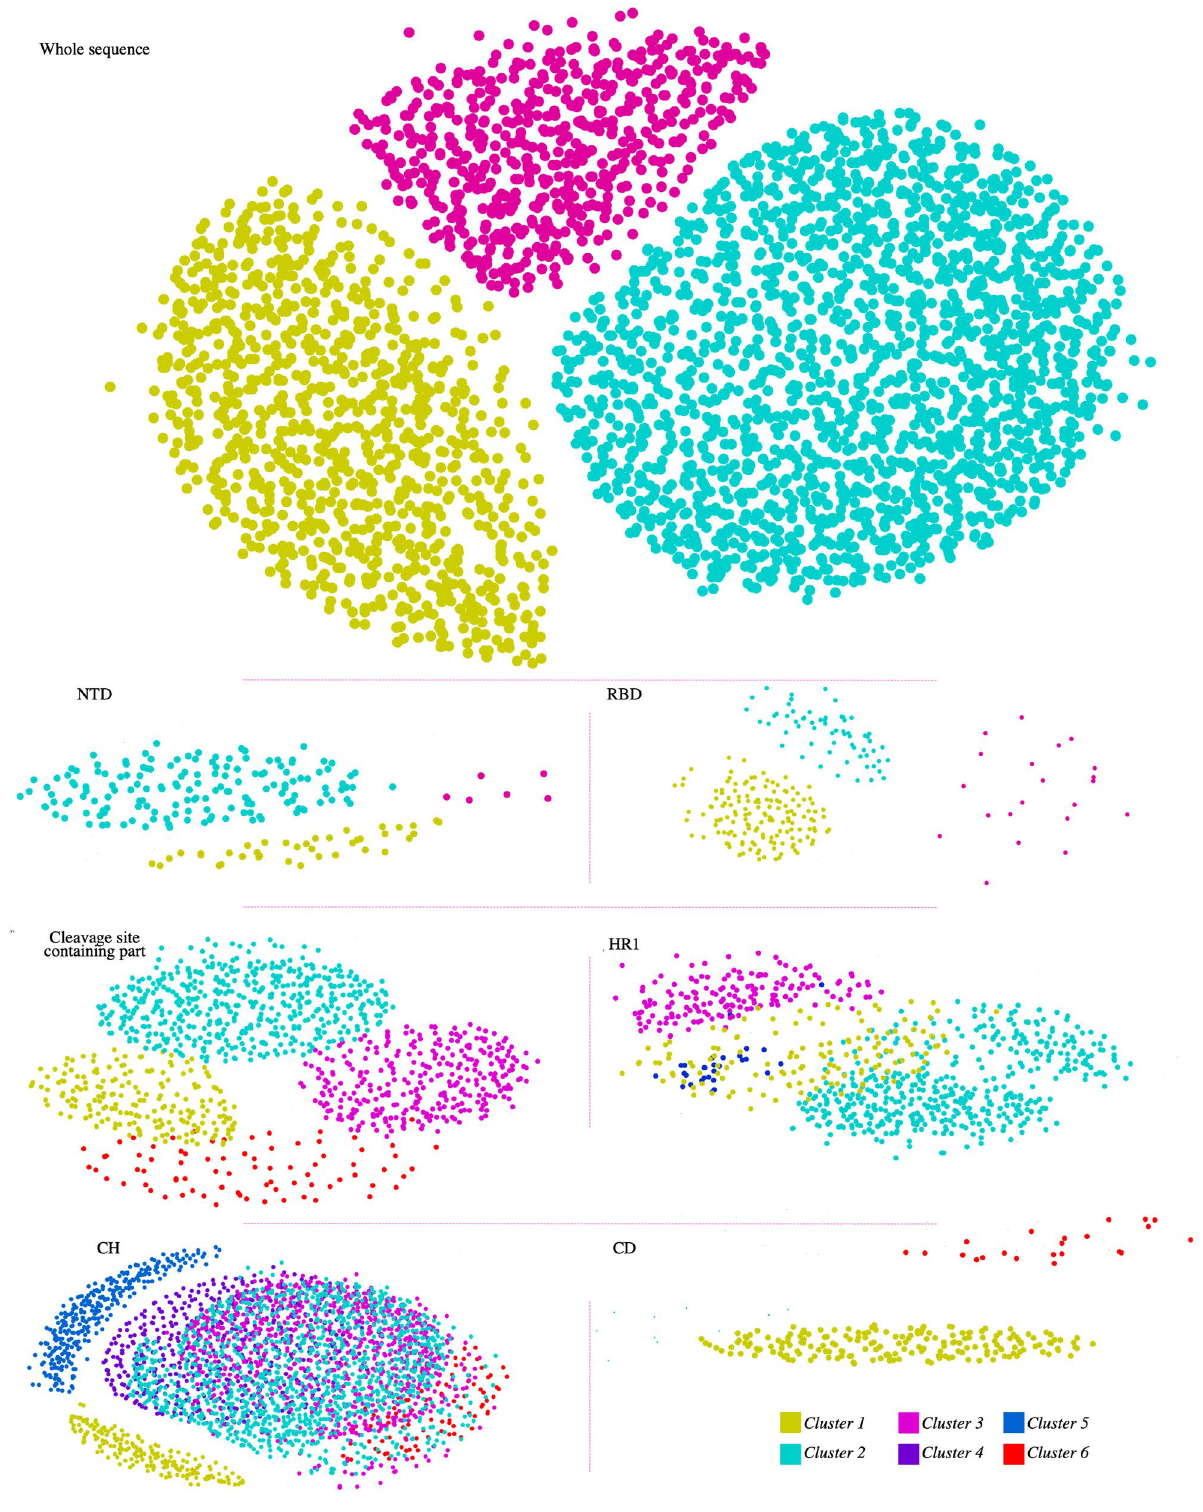
Figure 1. Visualization of the CLANS analysis results. Each panel shows the graphical two-dimensional representation of each dataset. Nodes represent the sequences in the analyzed dataset. Each sequence set includes the related domain and the corresponding homologous sequences derived from HMM profiling. The clusters are the results of the network-based clustering function of the CLANS software. The upper panel shows the clustering analysis from full-length sequences, and other panels are clusters from just the identified domain (labeled on the bottom left of each group). The nodes are colored based on the number of clusters (color key at bottom right). The sequence of Sgp SARS-CoV-2 or its domains is involved in cluster 1 in each group, except for the N-terminal domain (NTD); which is not involved in any cluster. The details of the clusters are summarized in Table